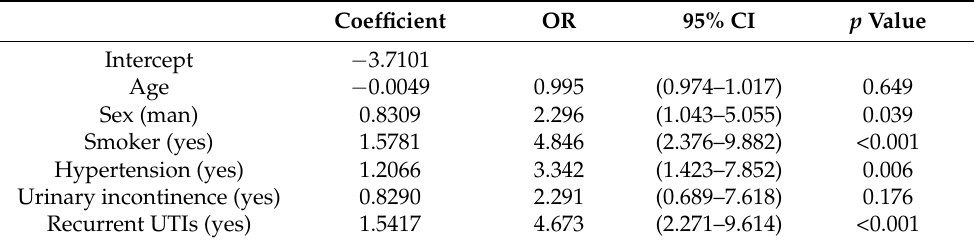
Table 4. Multivariate logistic model for the presence of extended-spectrum